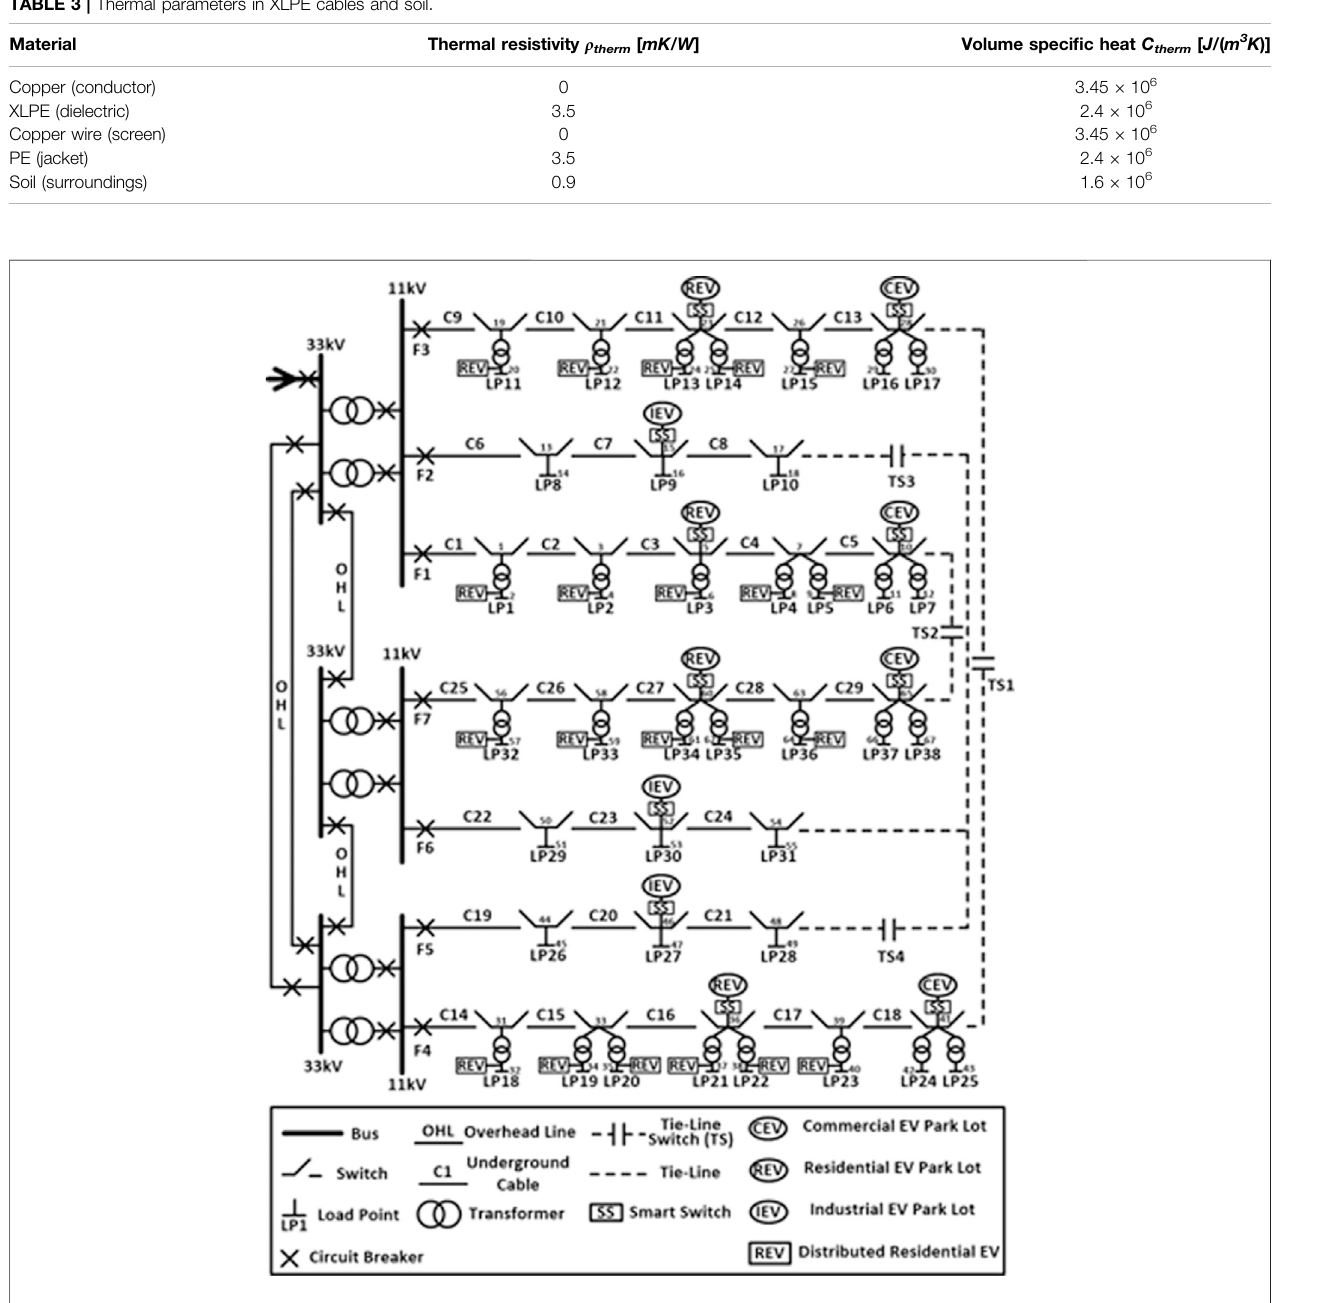
FIGURE 4 | Single line diagram of the modi fi ed RBTS bus four distribution network.